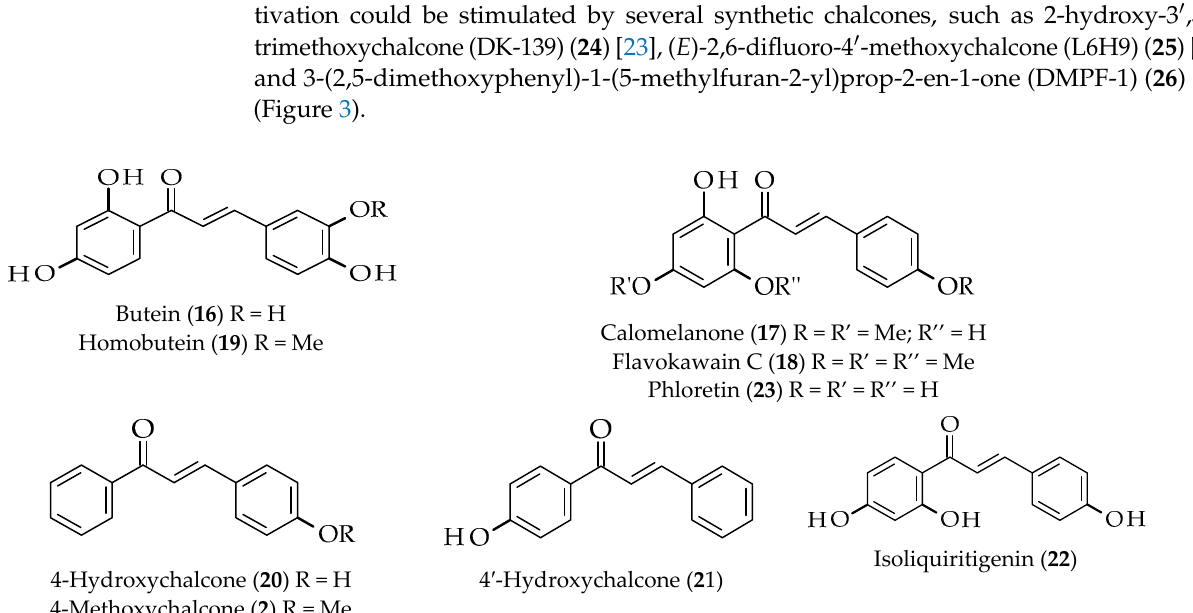
Figure 4. Examples of some naturally occurring chalcones that induce the NF- κ B